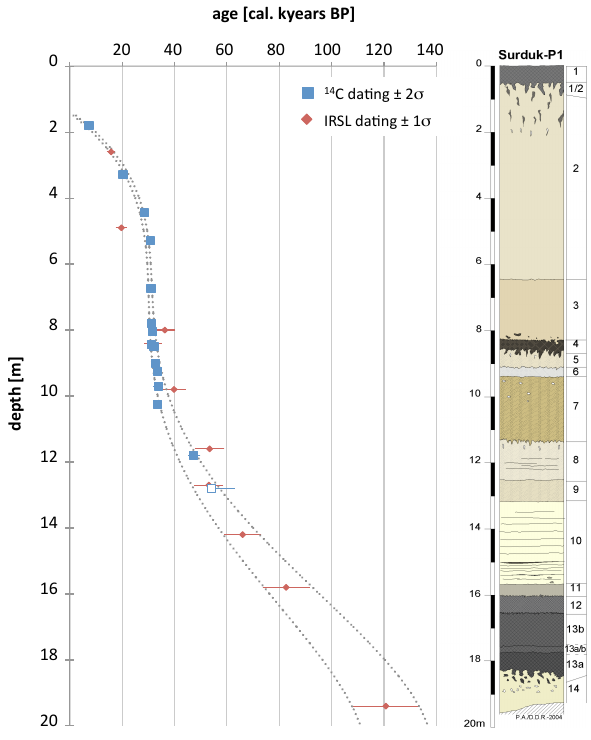
Fig. 3. Stratigraphy and age model of the Surduk loess sequence. Red diamonds are for IRSL dating; the error margin encompasses the 1 sigma variation range (Fuchs et al., 2008). Blue squares repre- sent Calib 6.0 calibrated 14 C dating (Reimer et al., 2009); the error margin encompasses the 2 sigma variation range. The open symbol represents the > 53000 14 C conv. year, for which we only have a minimum age. The dotted lines represent an age model envelope that should very likely encompass the chronology of the loess or- ganic accumulation. Major stratigraphic units are 14: Saalian loess; 13–12: basal soil complex; 11–10: lower loess; 9–4: middle soil complex; 3–2: upper loess; and 1: top soil (Antoine et al.,